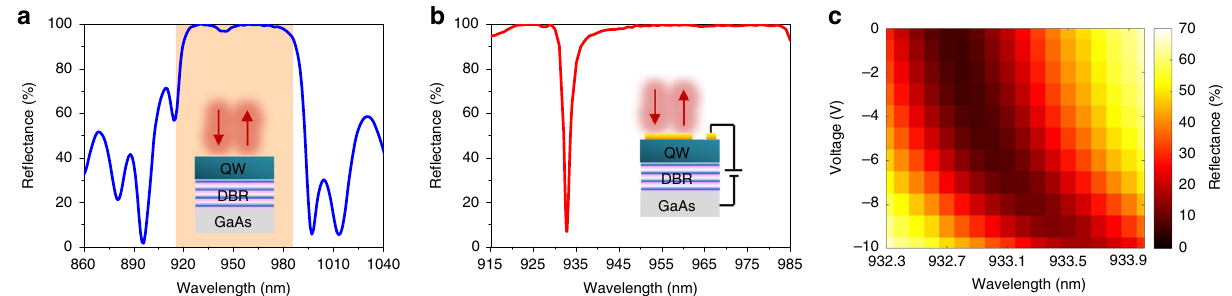
Fig. 1 Optical performance of MQWs. Measured re fl ectance spectra of ( a ) a bare DBR/MQW and ( b ) a DBR/MQW/Ti/Au Fabry – Pérot cavity under no applied bias. The insets show the schematics of corresponding structures. The light orange area in ( a ) indicates the wavelength range shown in ( b ). c Measured re fl ectance of the DBR/MQW/Ti/Au Fabry – Pérot cavity as a function of wavelength and